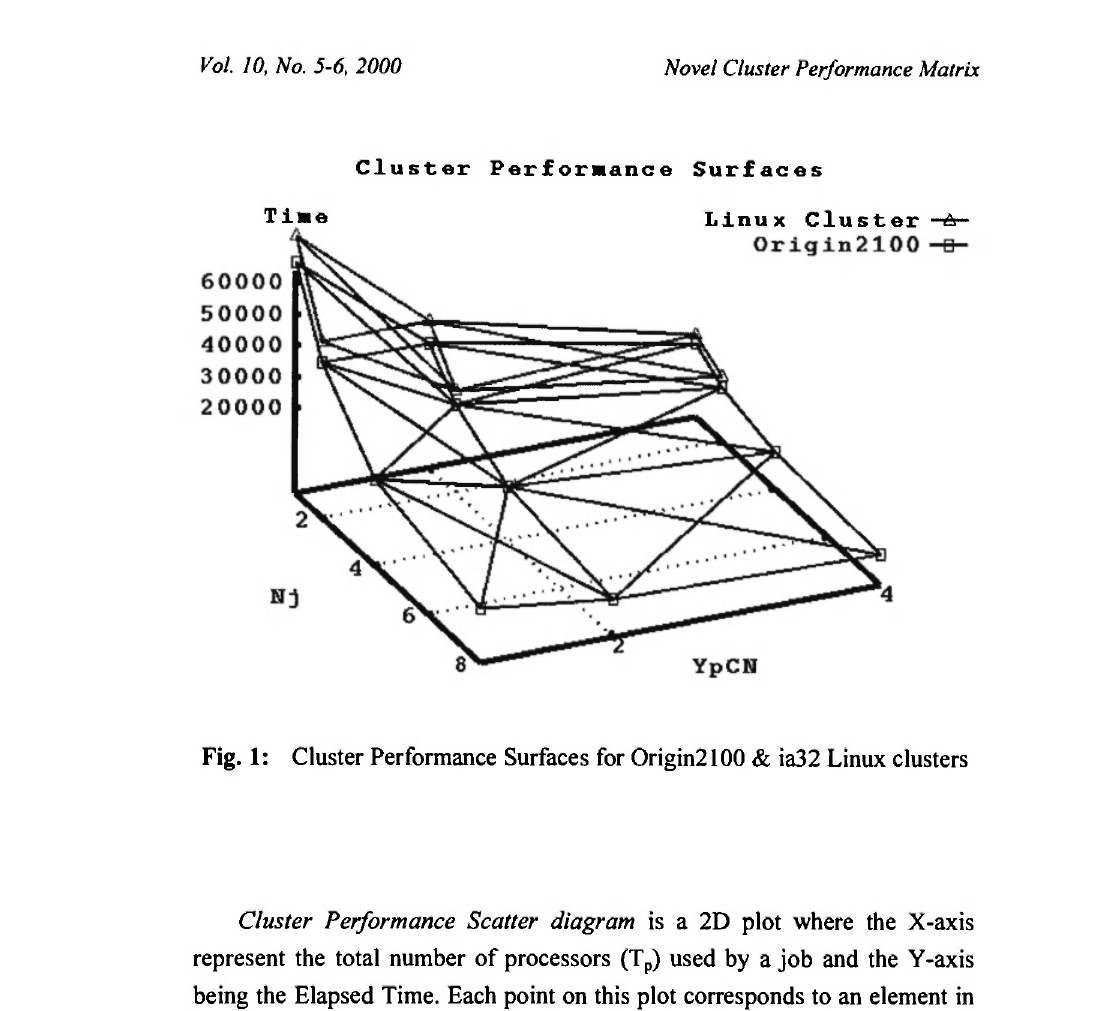
Cluster Performance Scatter diagram is a 2D plot where the X-axis represent the total number of processors (T p ) used by a job and the Y-axis being the Elapsed Time. Each point on this plot corresponds to an element in the corresponding